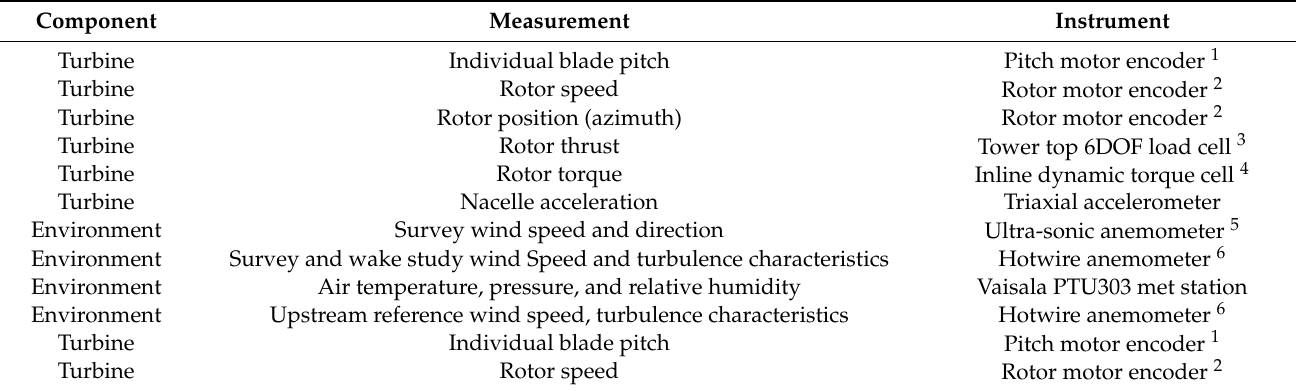
Table 1. Instrumentation channels.